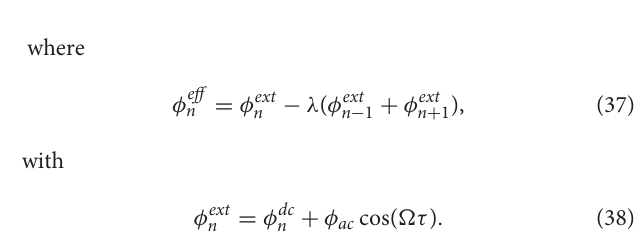
FIGURE 9 | (A) Map of h˙ φ n Equation (30). (B) Same as in (A) but with φ ac the driving period, of 10 6 values of desynchronized state shown in (C)